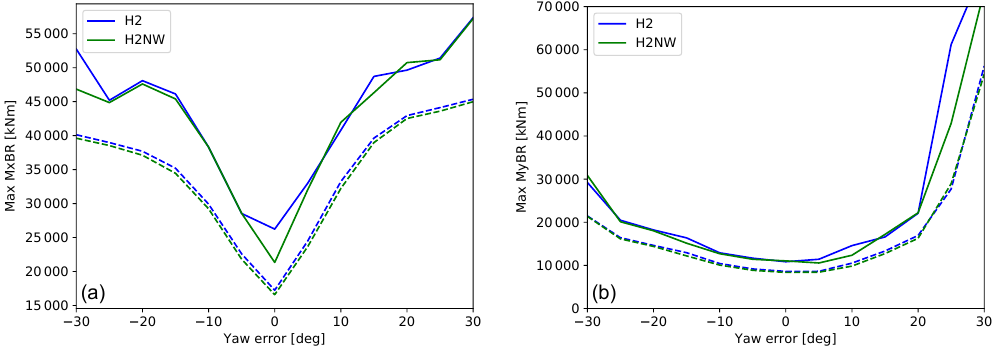
Figure 13. Maximum flapwise (a) edgewise and (b) blade root bending moment for wind directions between − 30 and 30 ◦ yaw error. Dashed lines show the mean of the maximum values for the 36 different seeds, the solid lines the maximum of the maxima.